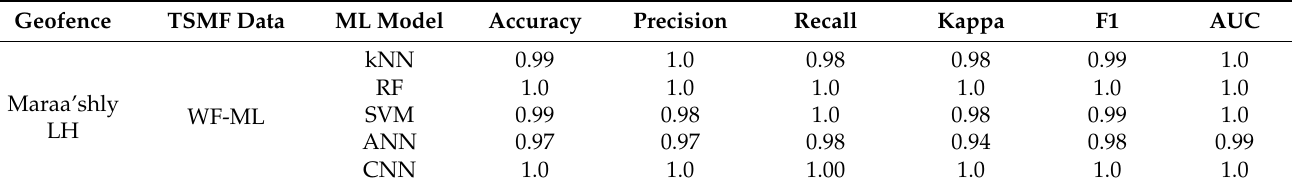
Table 2. Maraa’shly LH Indoor WF-ML results.